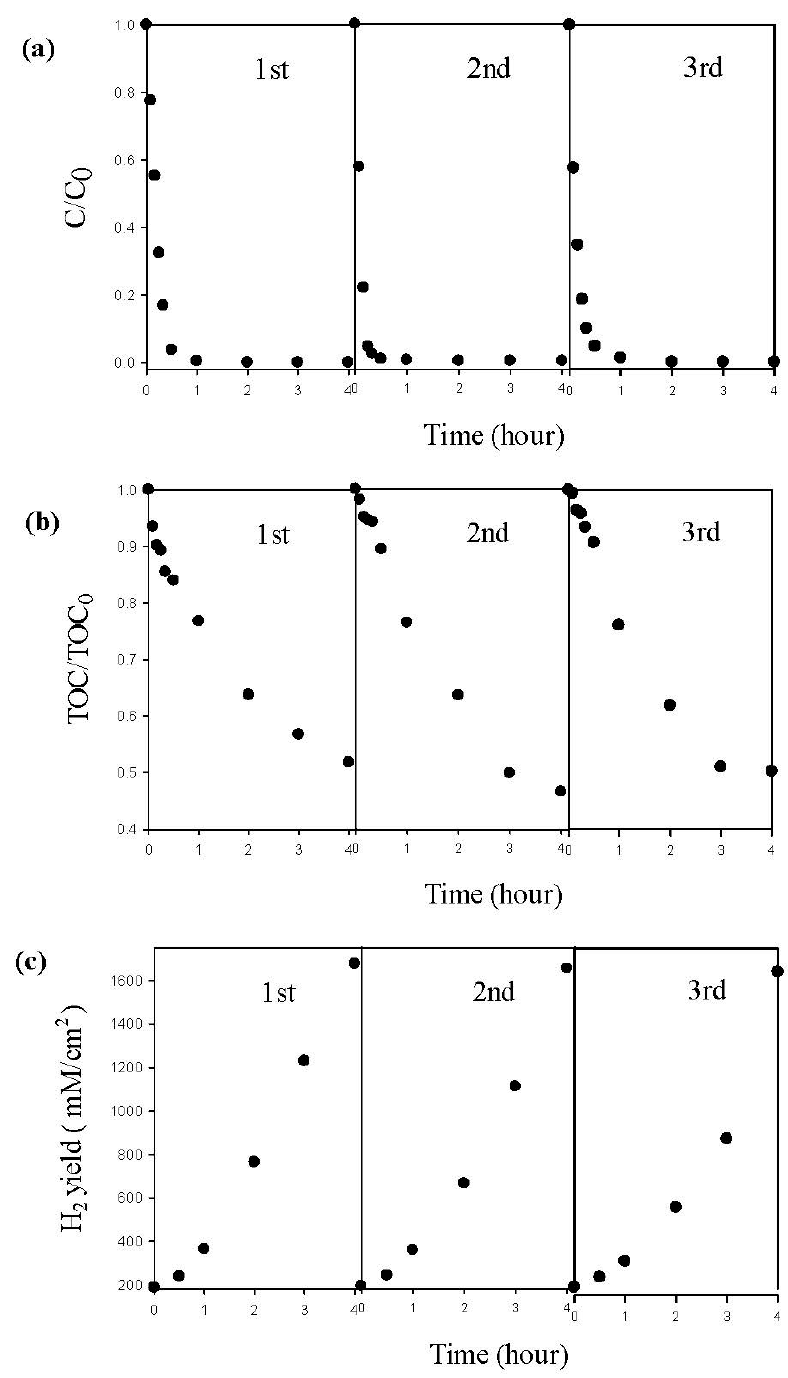
Figure 11. The repeated experiment by Pd/TNAs-C in photoelectrochemical (PEC) system ( a ) methyl orange degradation, ( b ) total organic carbon removal, and ( c ) hydrogen